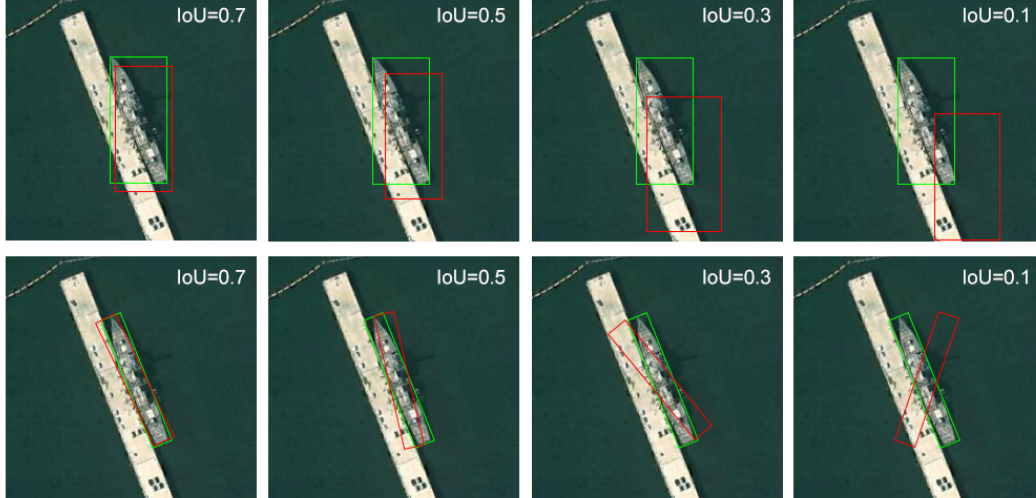
Figure 10. Rotated bounding box is very sensitive to angle variation, as a result, it is more difficult to be determined as “detected” than horizontal box under the same value of IoU